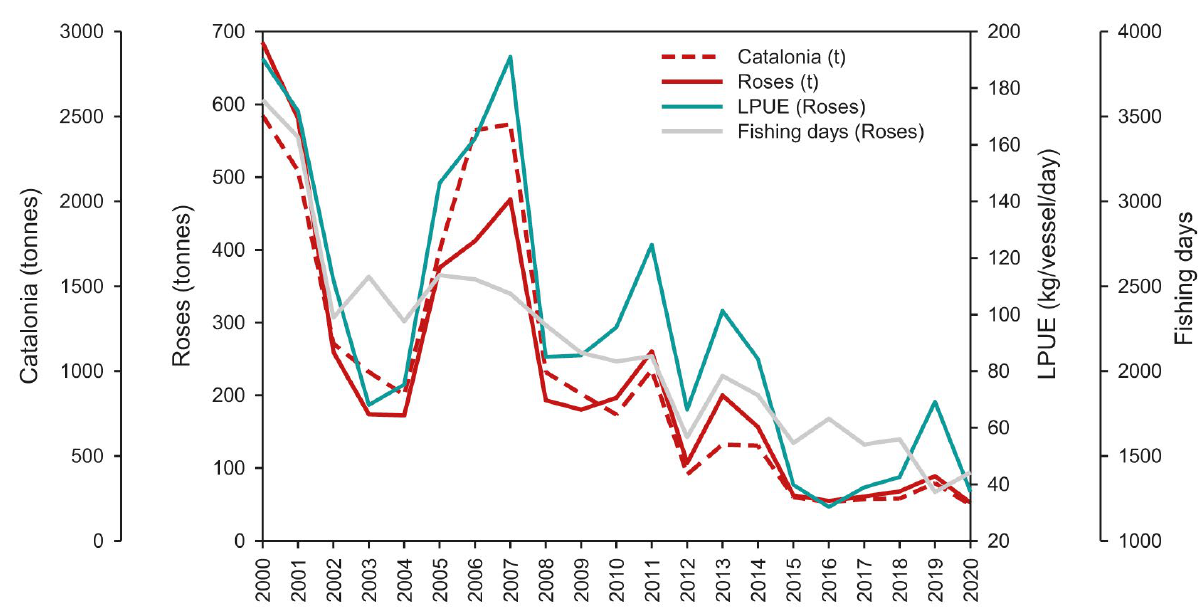
Fig. 2. − Blue whiting annual landings in tonnes on the coast of Catalonia (red-dashed line, left outer axis) and in Roses harbour (red line, left inner axis), LPUE in Roses (kg/day/vessel, green line, right inner axis), and fishing days in Roses (grey line, right outer axis).